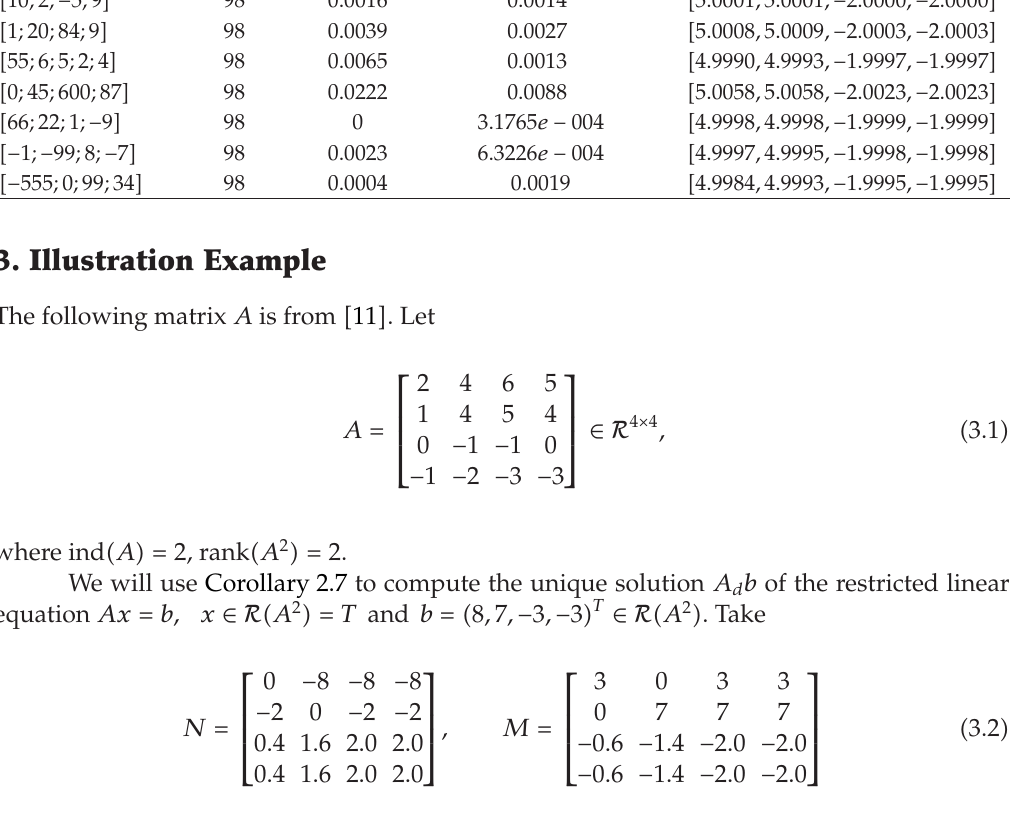
Table 1: Convergence of (cid:2) 2.6 (cid:3) with any choice of initial x x T k r k R k X T 0